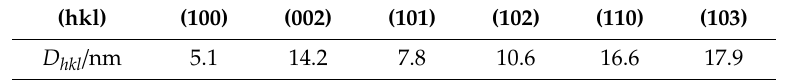
Table 2. Crystallite sizes of the Mg-RE alloy sheet, calculated by Scherrer equation.